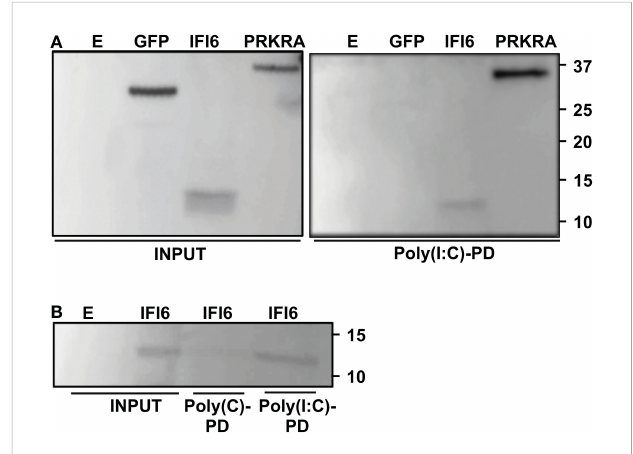
FIGURE 8 IFI6 binds poly(I:C). (A) Human 293T cells were transiently transfected with the pCAGGS plasmids encoding GFP, IFI6-HA and PRKRA-FLAG, or with an empty plasmid (E) Pull-down (PD) experiments using poly (C) (data not shown) and poly(I:C)-conjugated agarose beads were performed using cellular extracts. Western blotting using Abs speci fi c for GFP, the HA tag (to detect IFI6) or the FLAG tag (to detect PRKRA) was performed to detect protein in the cellular lysates (Input) and after the pull-down (poly(I:C)-PD). Molecular weight markers are indicated (in kilodaltons) on the right. (B) Recombinant IFI6 protein fused to 6xHis and GST was incubated with poly(C) and poly(I:C)-conjugated agarose beads. A Western blot using an Ab speci fi c for the GST tag (to detect IFI6) was performed to detect protein in the input and after the pull-down (polyC-PD and poly(I:C)-PD). Two independent experiments and Western blots were performed, with similar